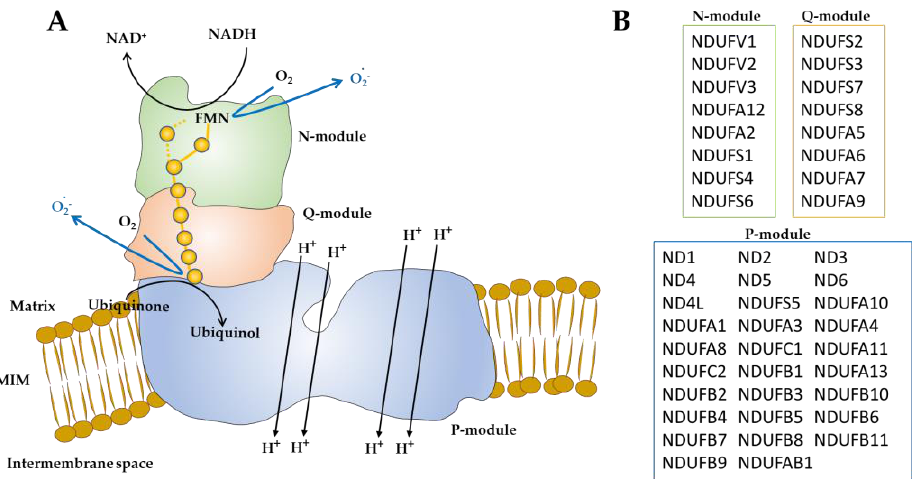
Figure 1. Schematic representation of mammalian complex I. ( A ) Complex I with “L” shape is shown in three distinct modules: N-module (in green), Q-module (in pink) and P-module (in blue). N and Q modules constitute the hydrophilic arm of complex I, exposed in the matrix [45]. The P-module constitutes the hydrophobic arm of the complex embedded in the mitochondrial inner membrane (MIM) [45]. The oxidation of NADH by FMN generates the electrons transfer, through the seven iron–sulfur clusters (yellow spheres), to ubiquinone molecule [44]. The reduction of ubiquinone induces conformational changes in the P-module. This results in proton pumping from matrix to intermembrane space. The reduced FMN, and probably the N2 iron–sulfur cluster, can also react with molecular oxygen (O 2 ) to form superoxide anion (O 2 · - ). ( B ) The complex I subunits belonging to N, Q and P modules are reported